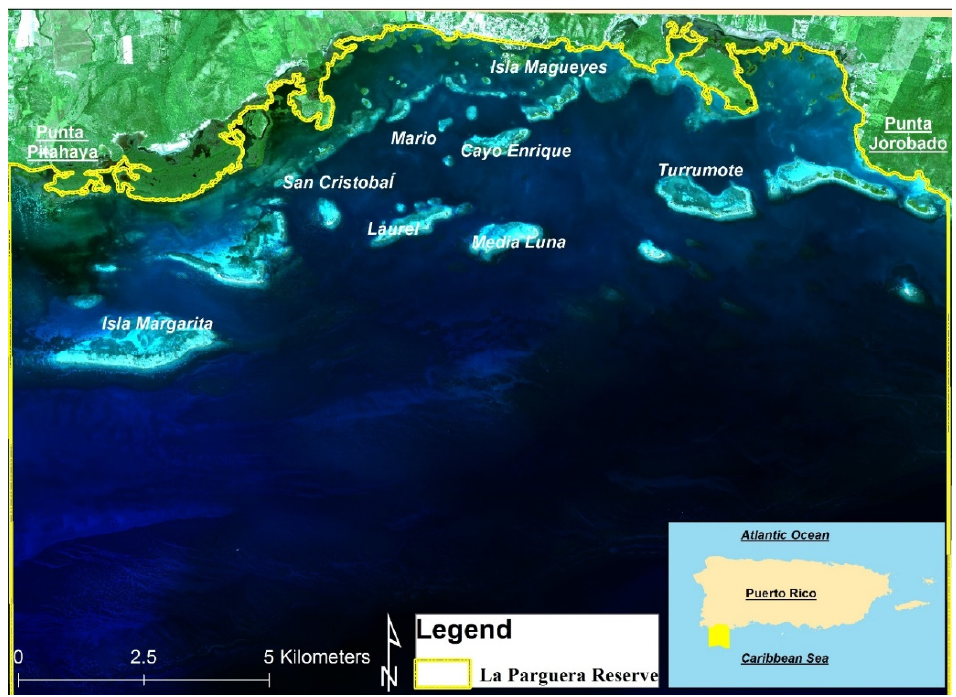
Figure 1. WV2 image of study area of La Parguera Reserve, Southwestern Puerto Rico.